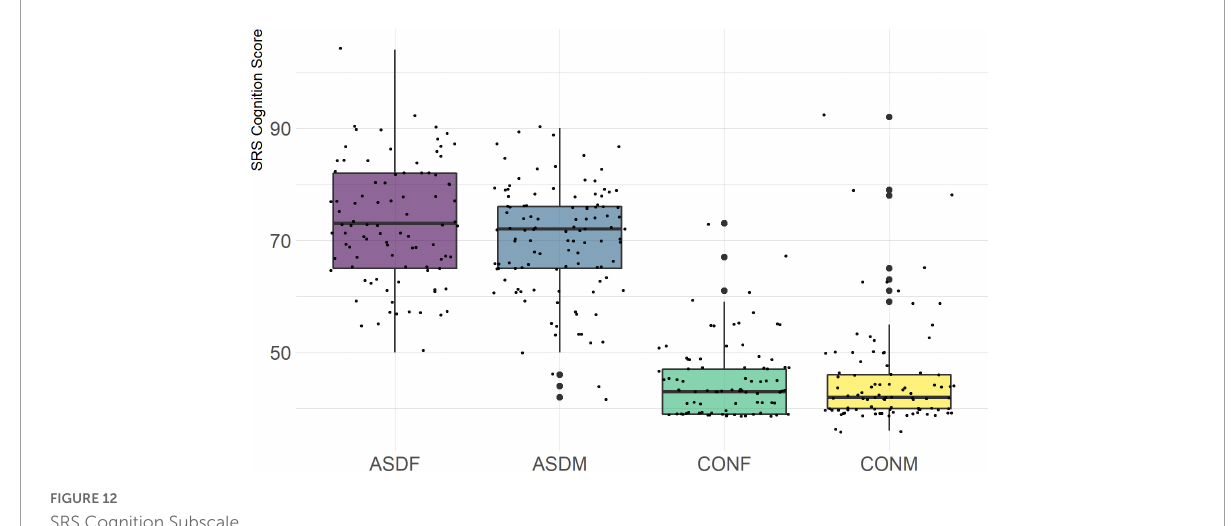
FIGURE12 SRS Cognition